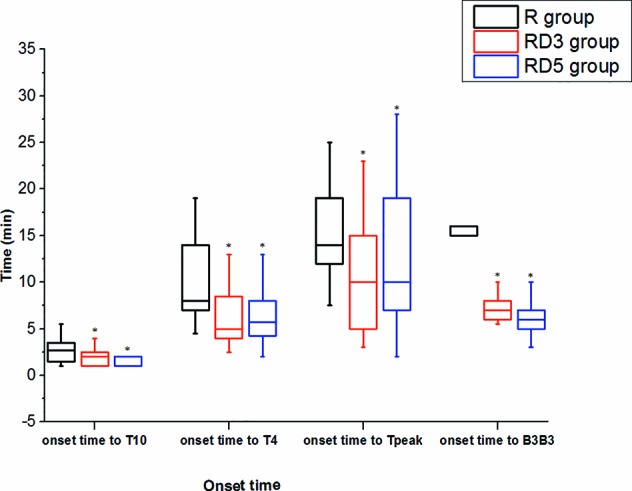
Onset times of sensory and motor block. *p < 0.05 was considered statistically significant compared with the R group.